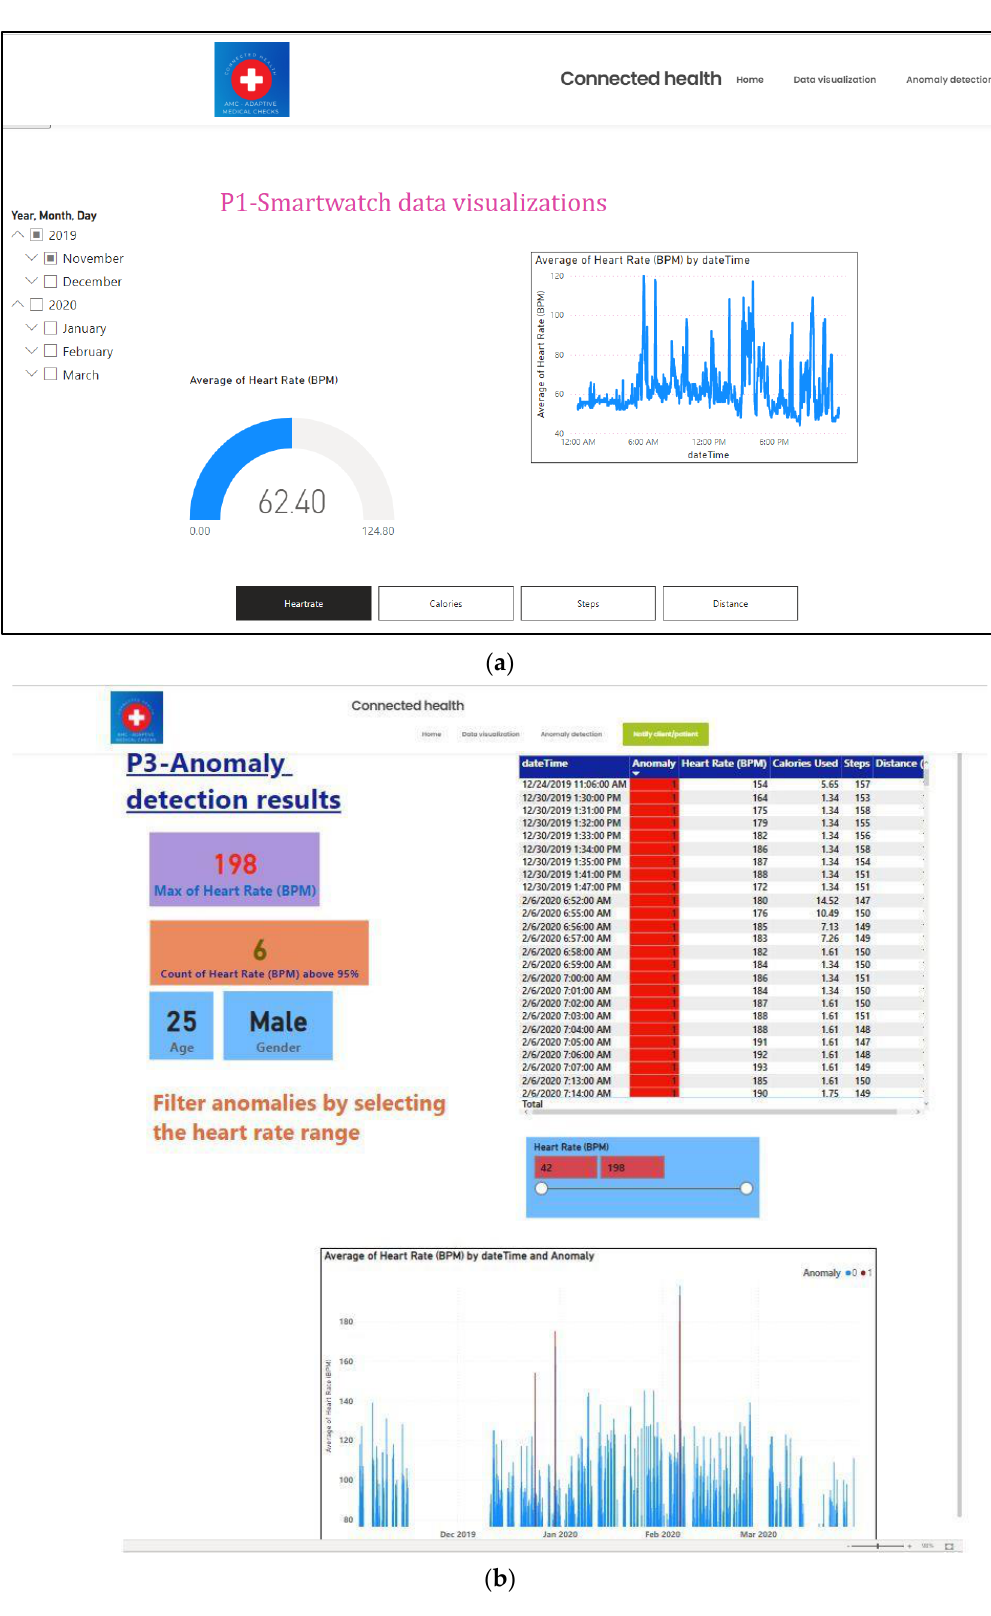
Figure 3. Web-based application prototype: ( a ) smartwatch data visualizations; ( b ) anomaly detec- tion